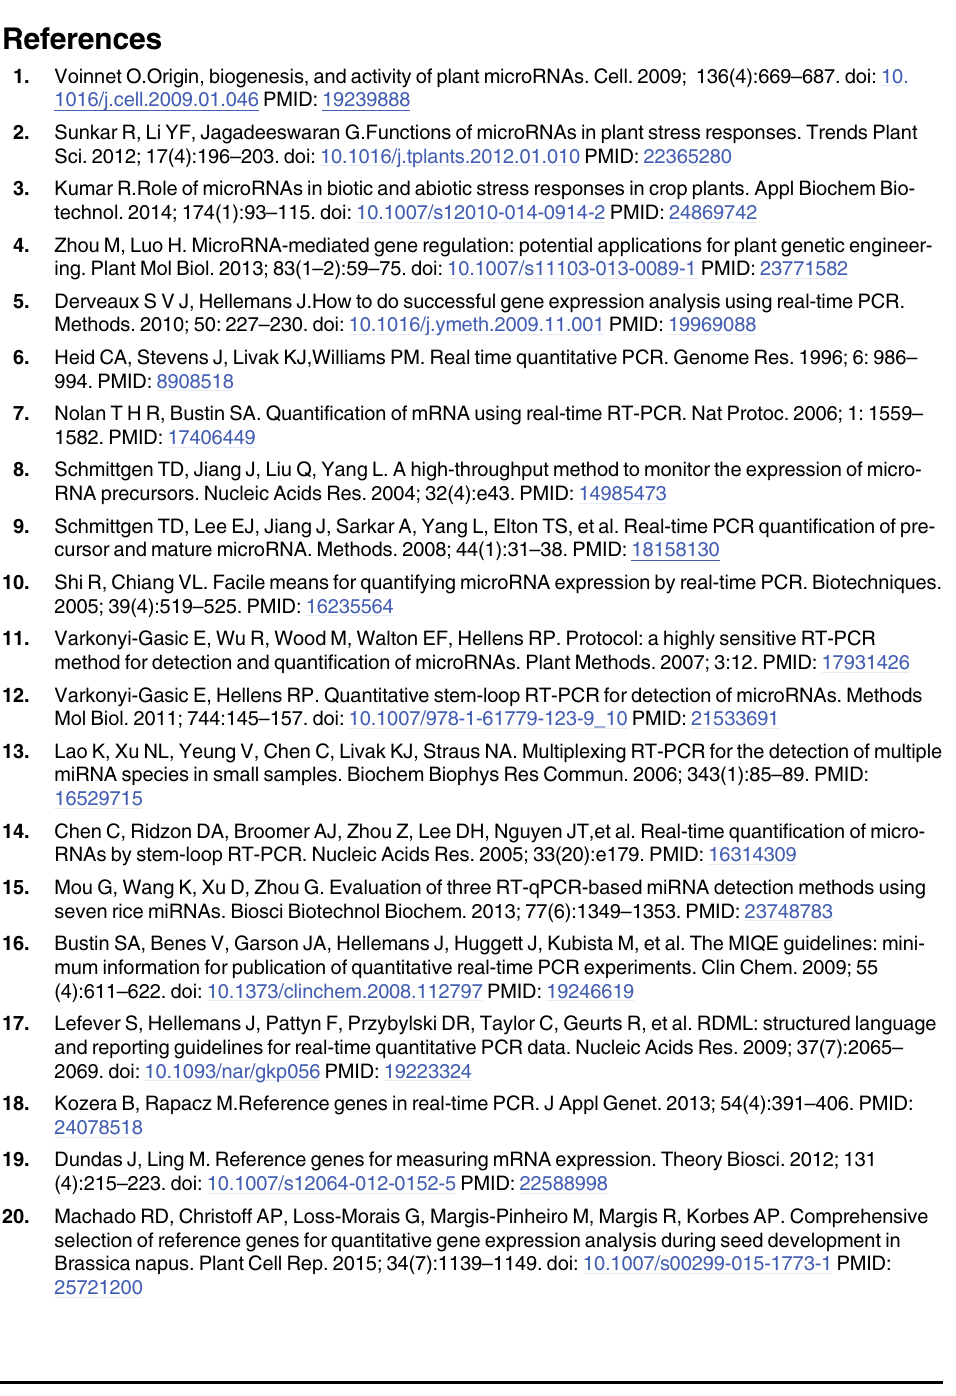
S1 Table. Description of the samples used for